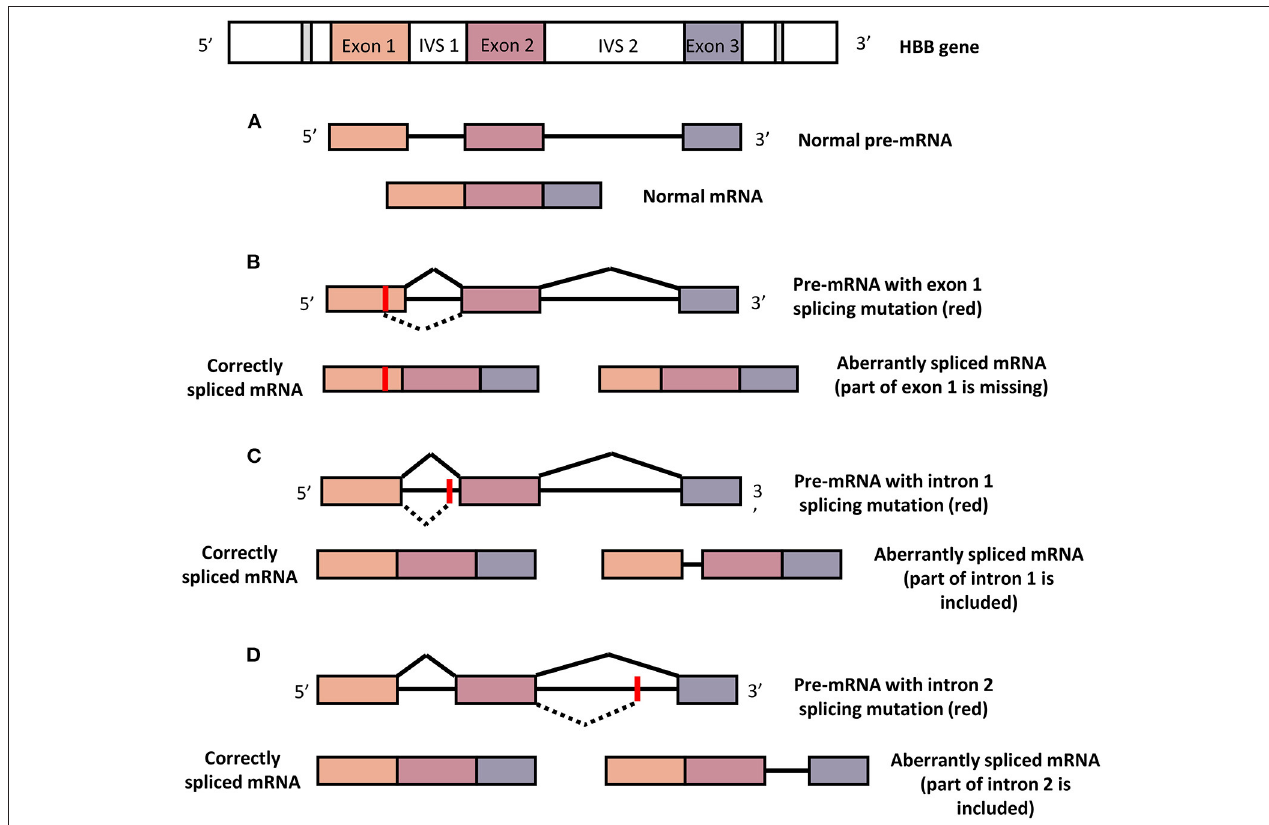
FIGURE 1 | Normal and aberrant splicing mechanisms. (A) Normal HBB produce normal pre-mRNA with intact three exons and subsequently translated into normal β -globin. (B) HBB with mutation in exon 1 that activates a de novo splice site may either produce correctly spliced or aberrantly spliced mRNA which later be translated into normal or no β -globin, respectively. (C) HBB with intron 1 mutation may activate correct or aberrant splicing pathways that give rise to normal or no β -globin, respectively. (D) Intron 2 mutation in HBB may induce correct or aberrant splicing mechanisms that yield normal or no β -globin, respectively. Red point marked the mutation location. Dashed line indicates the aberrant splicing